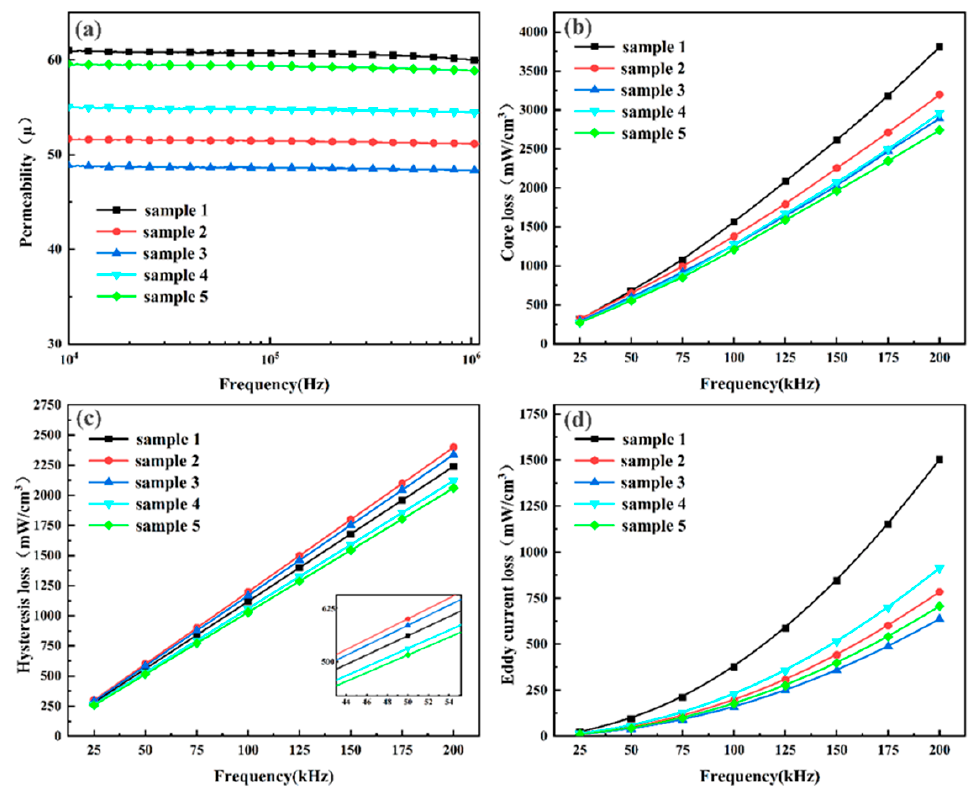
Figure 6. The effective permeability ( a ), the total core loss ( b ), hysteresis loss ( c ), and eddy current loss ( d ) as a function of the frequency for samples 1–5.